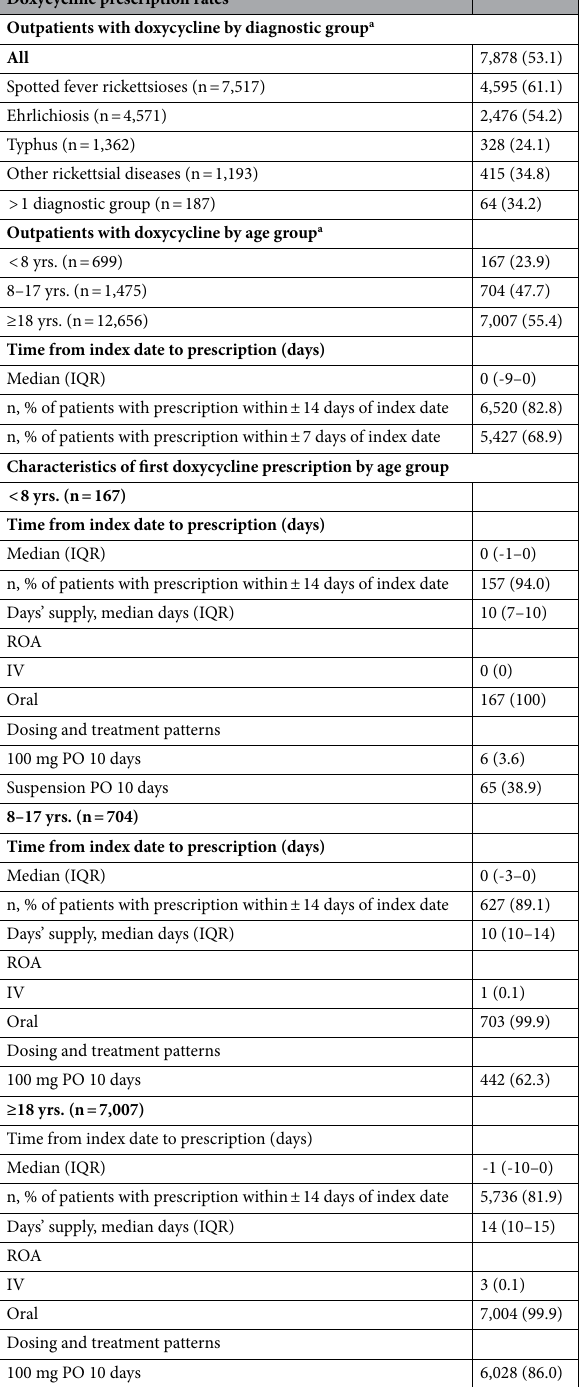
Table 2. Doxycycline treatment patterns by diagnostic and age groups among outpatients diagnosed with rickettsial diseases in a large, commercially insured population — United States, 2005–2017. Data are presented as No. (%) unless otherwise indicated. ROA route of administration, IV intravenous, mg milligrams, PO by mouth. Recommended dosing is 100 mg twice daily for adults or children ≥ 45 kg, and 2.2 mg/kg/dose twice daily for children < 45 kg. Duration of treatment is 5–7 days or at least 3 days after fever subsides or patient shows signs of clinical recovery. a Percentages reflect the proportion of patients within that diagnostic or age category who received the recommended dosing and duration of doxycycline. Remaining patients either received a non-recommended dosing/duration of doxycycline or no prescription was identified in the